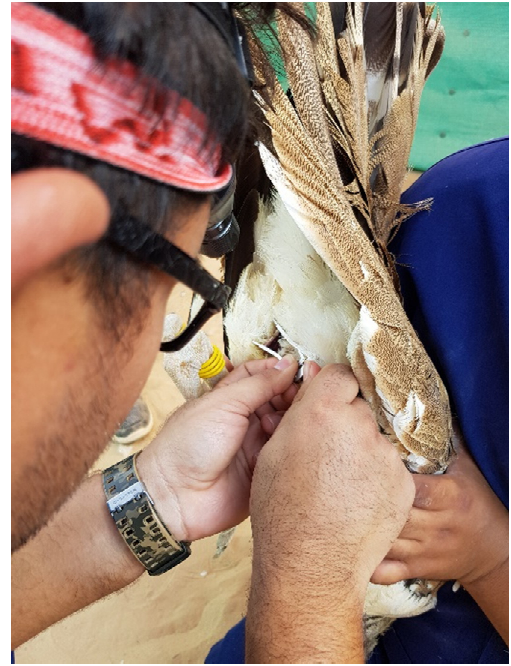
Figure A6. Artificial insemination of an Arabian bustard female.